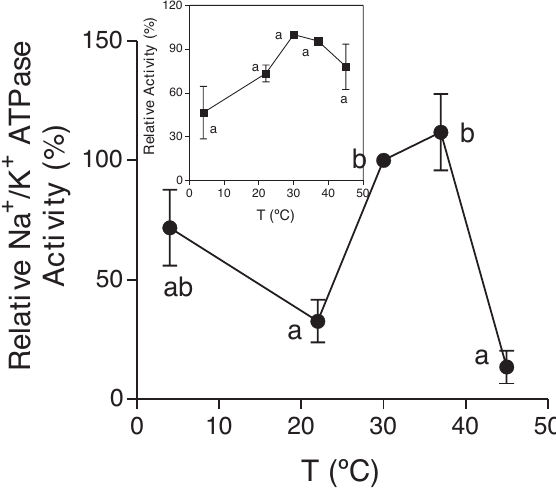
f ig . 3. – effect of temperature on na + -K + atPase activity at pH 7.4 in chela muscle of C. angulatus . inset: residual (Mg 2+ -na + ) atPase activity. the values of na + -K + atPase and residual (Mg 2+ -na + ) atPase activities are expressed as a relation to the corresponding activity at 30°C (100%, na + -K + atPase activity: 135.9 ± 70.2 and (Mg 2+ -na + ) atPase activity: 105.3 ± 23.1 nmoles Pi x min -1 x mg prot -1 ). in some cases, deviation bars were smaller than the symbols used. data are the mean ± S.e. for three individuals. different letters